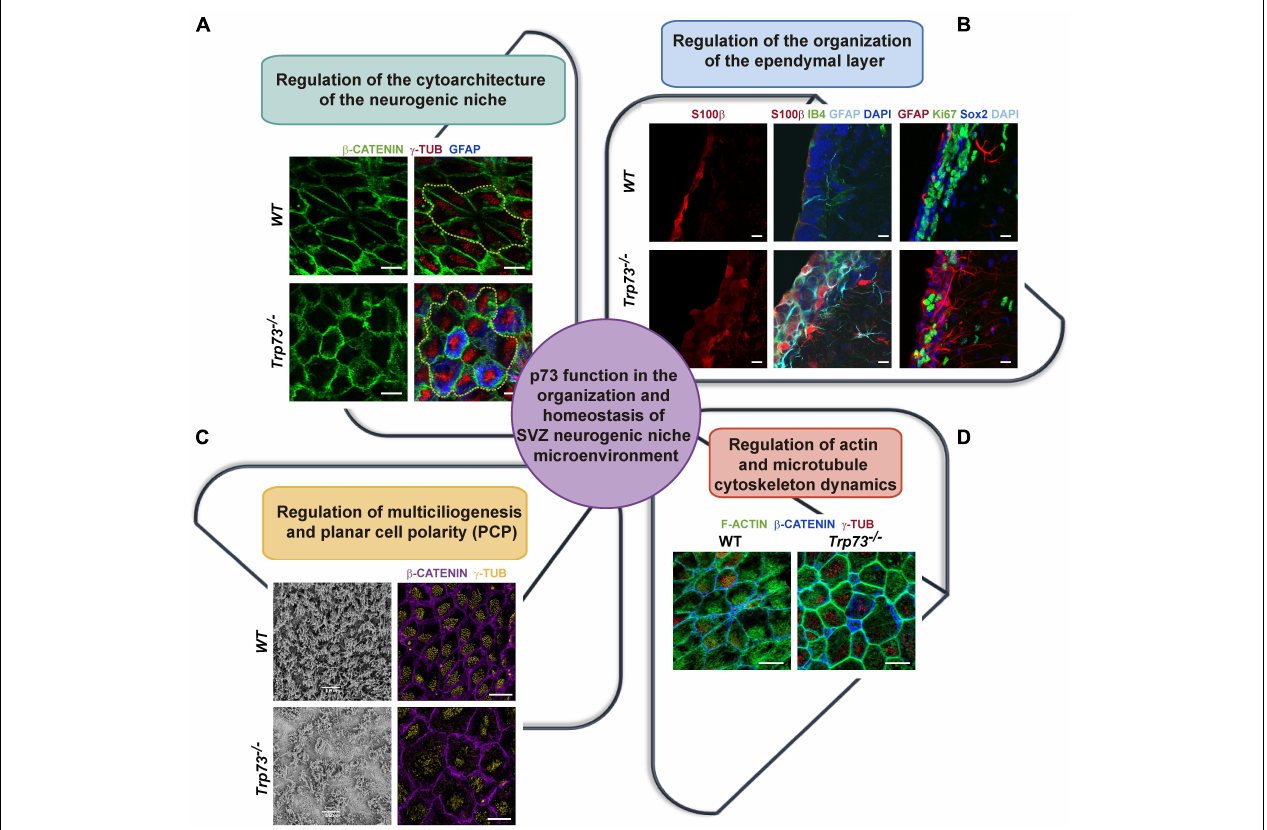
FIGURE 2 | p73 role as an architect of the SVZ neurogenic niche. (A) p73 is essential for the formation of the neurogenic pinwheels. In the absence of p73, EpCs show an aberrant membrane morphology and fail to organize into pinwheels, disrupting SVZ niche cytoarchitecture. Analysis of lateral ventricle wall whole-mounts of the indicated genotypes at postnatal day P160 immunostained for b-catenin (green), g-tubulin (red), and GFAP (blue). Pinwheel structures are marked by dotted yellow lines. Scale bars: 10 mm. (B) p73-deficient EpCs cell-junction defects compromise the integrity of the ependymal layer and halt the formation of the mono-stratified epithelium. In addition, cells with abnormal marker expression profiles are observed in p73KO brains. Coronal sections of the lateral wall of the lateral ventricle from P15 WT and p73KO mice were stained with the indicated antibodies and analyzed by confocal microscopy. Scale bars: 10 mm. (C) p73 is required for ciliogenesis and planar cell polarity establishment. p73KO cells displayed an abnormal cilia organization and basal body-cluster displacement. SEM (P7 mice) and confocal microscopy analysis (P15 mice, γ -tubulin, yellow; β -catenin, purple) of WT and p73KO lateral ventricle wall wholemounts. (D) p73 is also necessary for the formation of the polarized apical and sub-apical actin lattices in EpCs. Confocal images of WT and p73KO P15 wholemounts displaying as indicated: actin cytoskeleton (phalloidin, green), basal bodies ( γ -tubulin, red) and the cell membrane ( β -catenin, blue). Images from Dr. Marin’s research group (Gonzalez-Cano et al., 2016, Fuertes-Alvarez et al.,